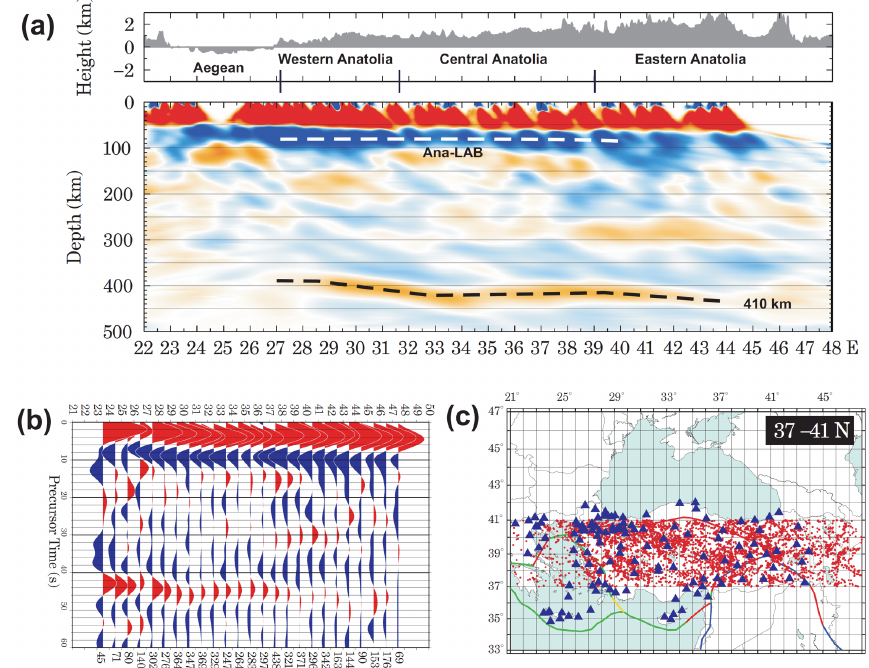
Figure 9. Same as Fig. 5 for an east–west profile between 37 and 41 ◦ N along central Anatolia. LAB (white dashed line) and Moho (black dashed line) are marked in (a) and (b) . Both phases are strong signals and slightly dipping from west to east. The Moho is on average in the west at about 25km depth and in the east at about 40km depth. The LAB depth deepens from about 80km in the west to about 90km in the east. Below the Aegean we see indications of the subducting African LAB.